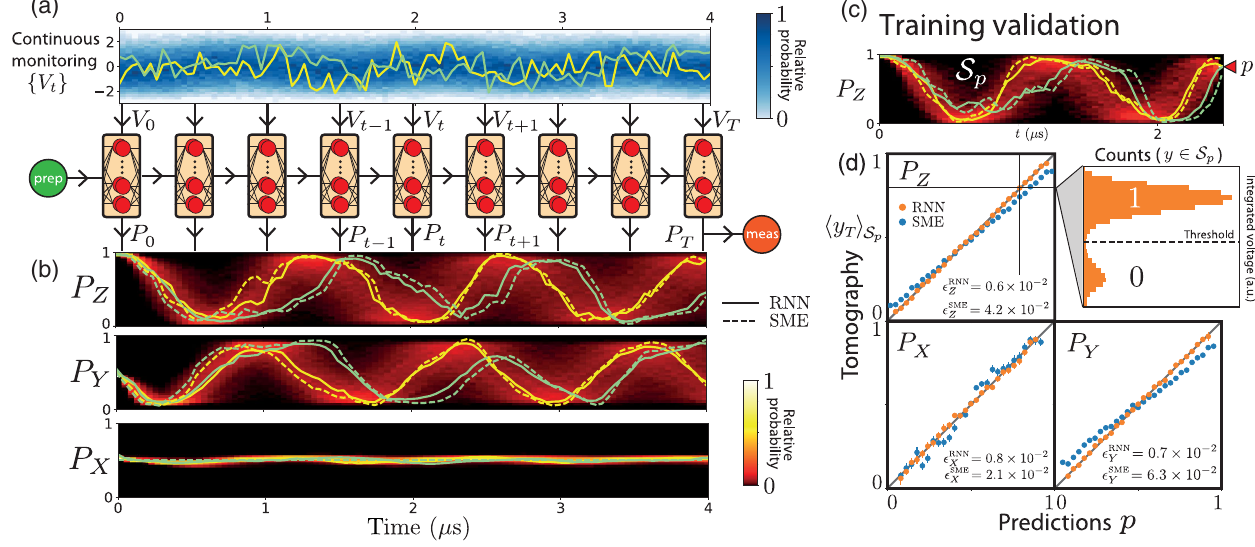
FIG. 2. RNN prediction of the quantum evolution. (a) Blue-scale histogram of the normalized measurement records extracted from the experiment; traces plotted in color show two representative instances. (b) Red-scale histograms of RNN prediction for the measurement basis b ¼ X , Y , and Z in the driven case, beginning from y 0 ¼ 1 in the preparation basis a ¼ X . Traces plotted in color show the two representative predictions from the measurement records by the RNN (plain line) and by the stochastic master equation (dashed line). (c) Training validation; red-scale histogram of the RNN prediction leading to p (cid:3) δ ¼ 0 . 85 (cid:3) 0 . 015 at T ¼ 2 . 5 μ s indicated by the red maker. This subset of trajectories belongs to the validation subset S p . (d) Comparison of the RNN prediction with the tomography. The tomography h y T i S ( y axis) is given by the projective measurement outcome along X , Y , and Z quadratures averaged over the subset of p trajectories S p leading the prediction p ( x axis). The orange dots correspond to the RNN predictions, and the blue dots correspond to the SME predictions. The average errors ϵ X;Y;Z shown in the plots are used to quantify the agreements between the prediction and the tomography; it is calculated based on the method explained in the validation section of the main text. Inset: Histogram corresponding to the integrated voltage during the projective measurement for the quantum trajectory subset S p for p ¼ 0 . 85 (cid:3) 0 . 015 . The threshold is used to discriminate the 0 and 1 states, leading to a tomography prediction h y T i S ¼ 0 . 85 in perfect agreement with the RNN prediction. p The SME prediction indicates S p